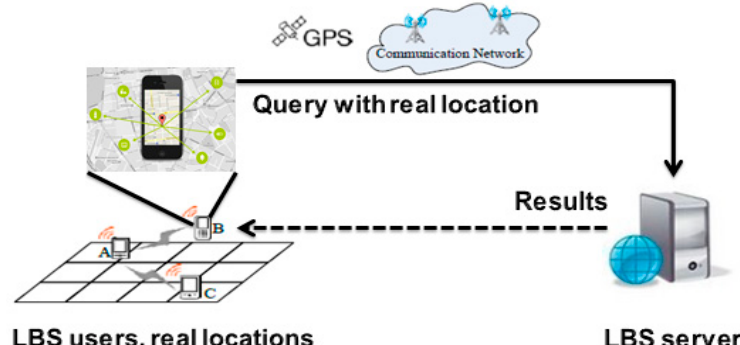
Figure 1. The classical scenario of LBS applications.